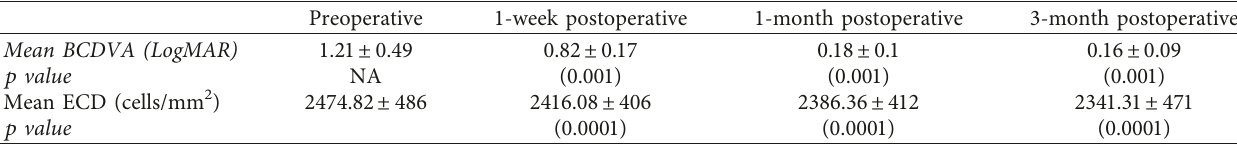
Table 2: Preoperative and postoperative mean BCDVA and ECD at 1 week, 1 month, and 3 months.